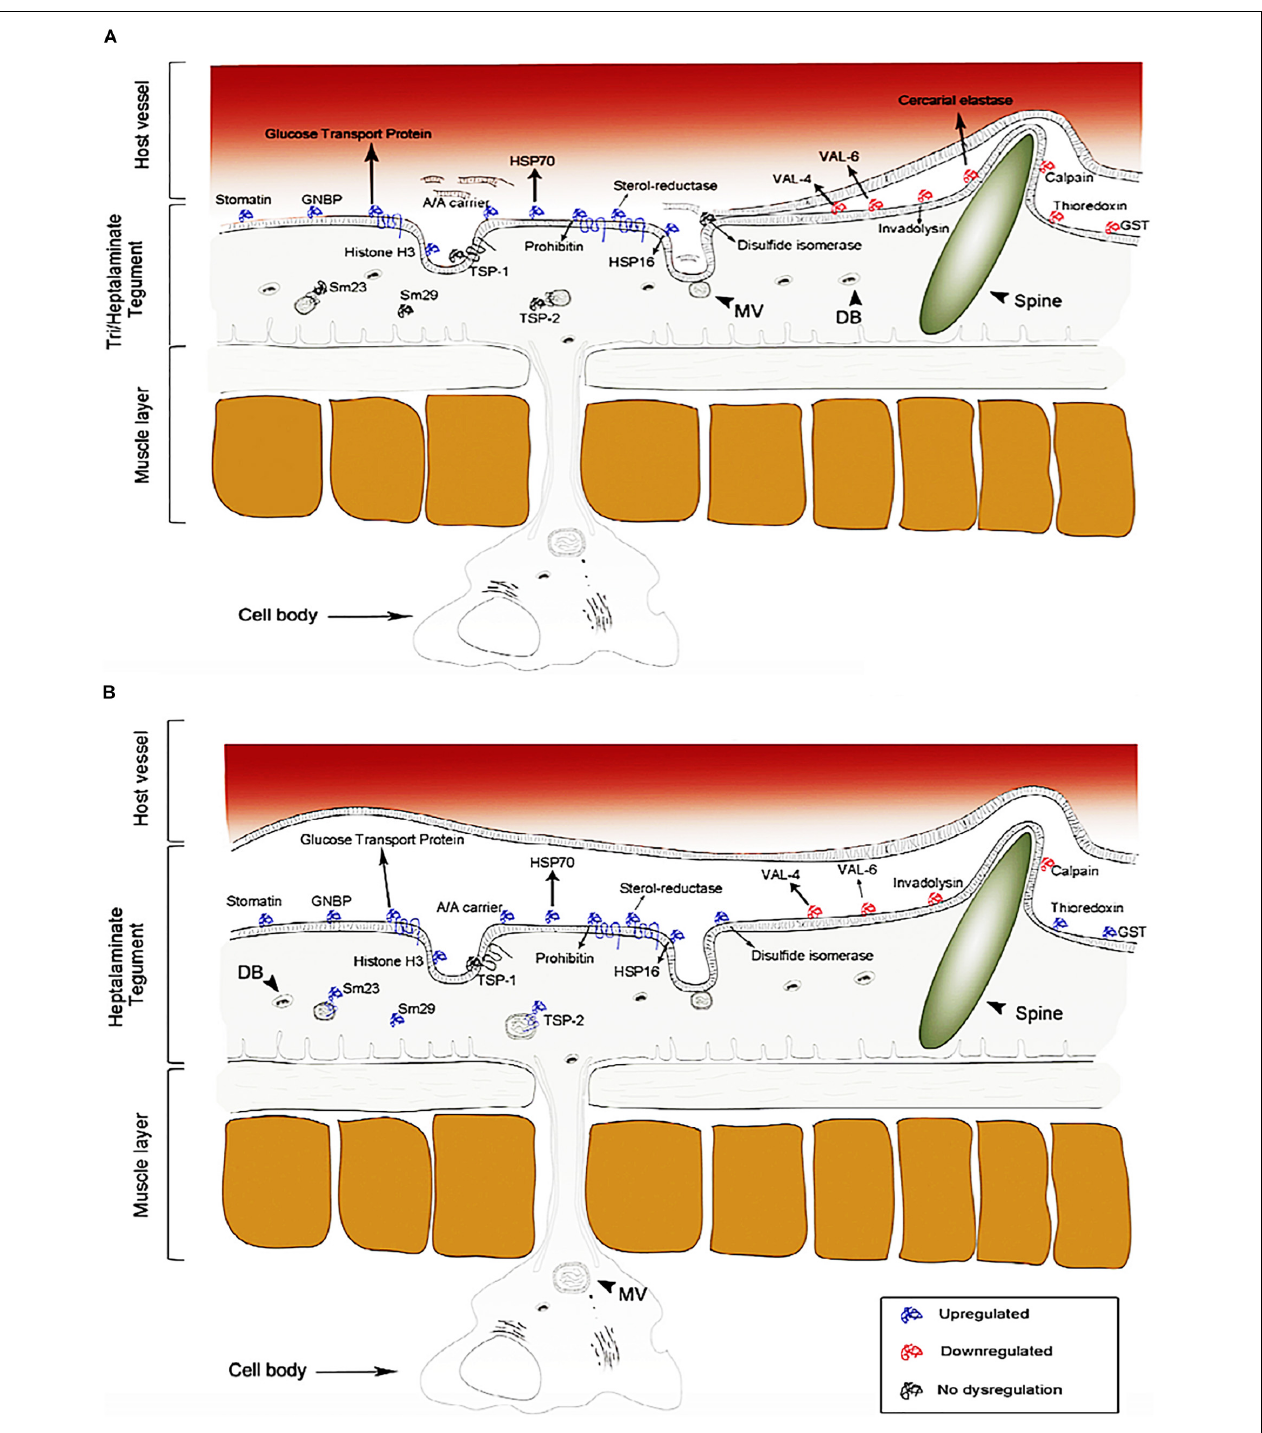
FIGURE 4 | Proteome identification of upregulated, downregulated and no dysregulation proteins found on the tegument of S. mansoni (schistosomula). The dysregulation of these proteins changes over time. (A) 3 h of infection and (B) 5 days of infection (reprinted with permission from Sotillo et al., 2015).